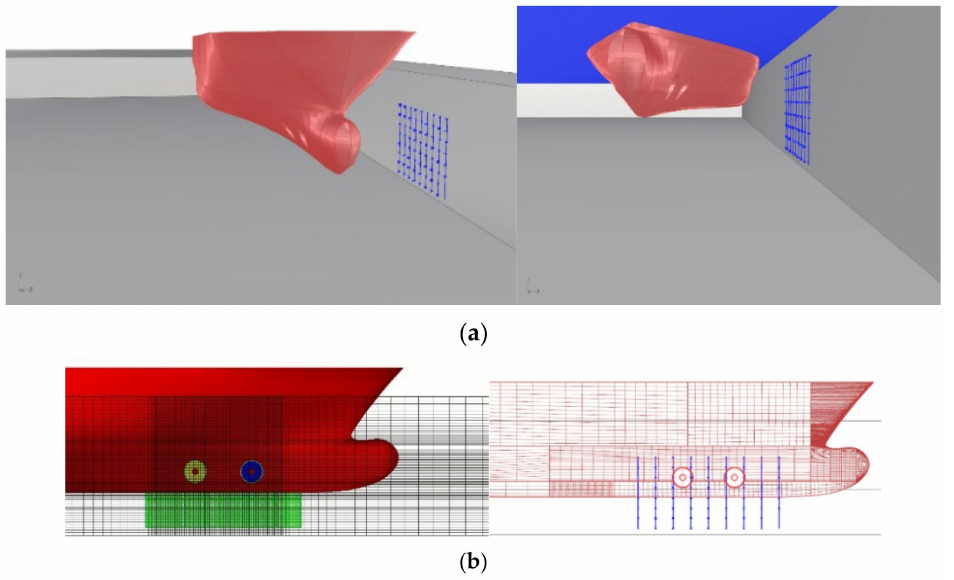
Figure 2. Model of the quay wall with the pressure sensors positions: ( a ) geometry of the maneuvering area, hull form model of Ferry 2 and grid of pressure sensors positions; ( b ) overlapping meshes applied for the simulations.